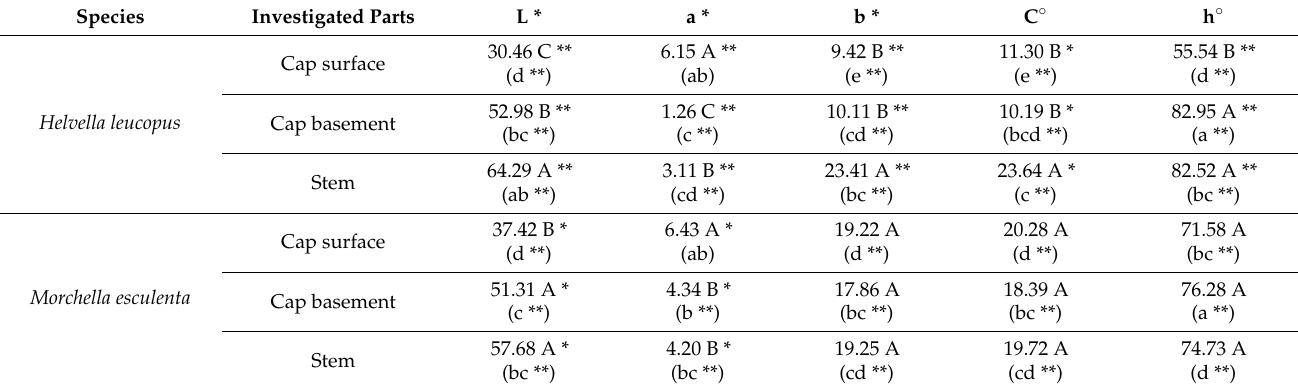
Table 3. Determination of color values (L, a, b, C, h) in naturally grown some macro-fungi species.